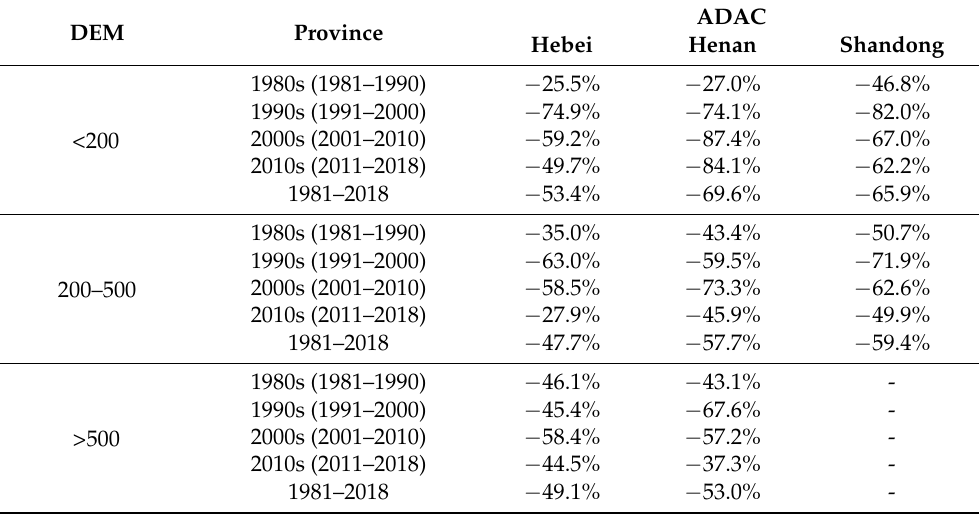
Table 2. Decade agricultural drought-affected area changes (ADAC) of three topographic classes during 1981–2018 for Hebei, Henan and Shandong Provinces.